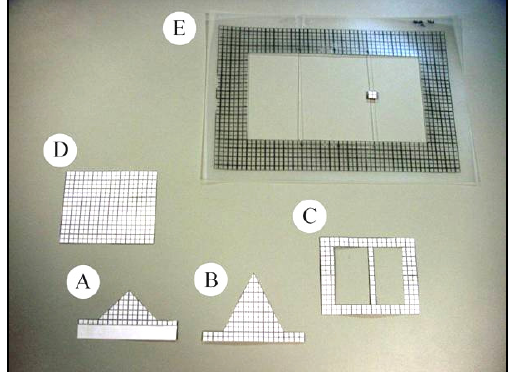
Figure 5. Shutter templates: (A) Triangle A. (B) Triangle B. (C) 5 mm wide rectangular strip. (D) Rectangle (10 × 8 cm). (E) Template frame and 1 cm 2